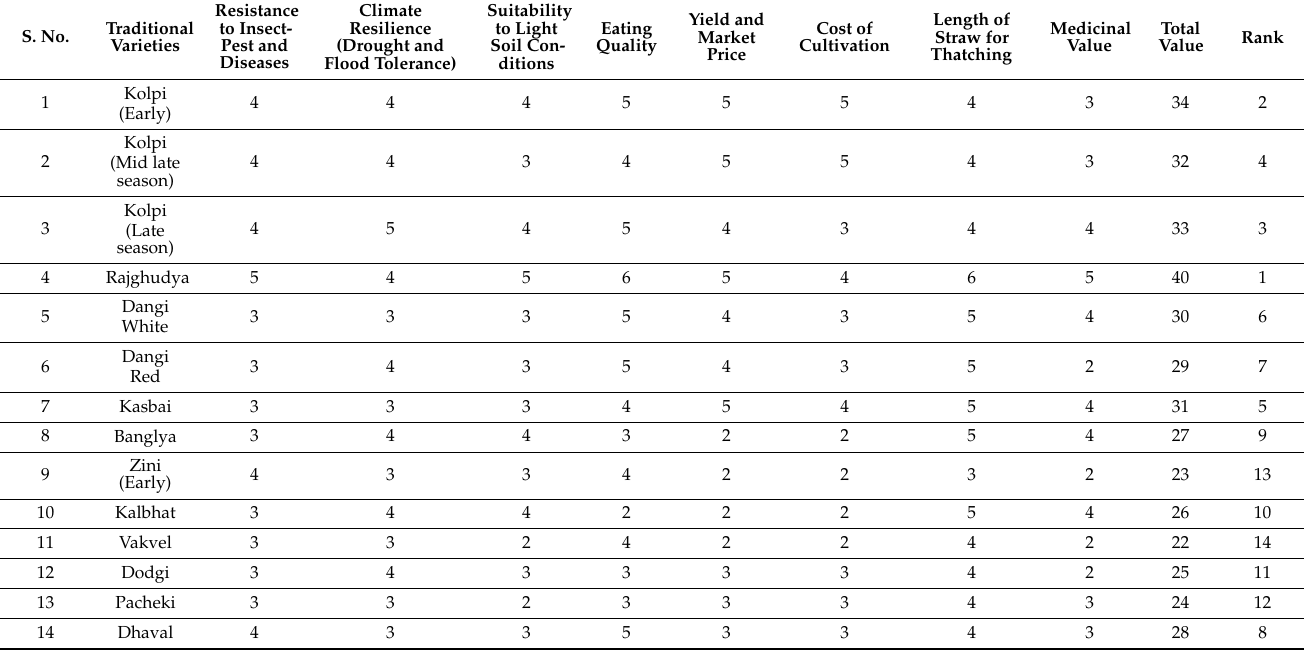
Table 3. Matrix ranking for the traditional rice varieties in Palghar district of Maharashtra in WGR. S. No.